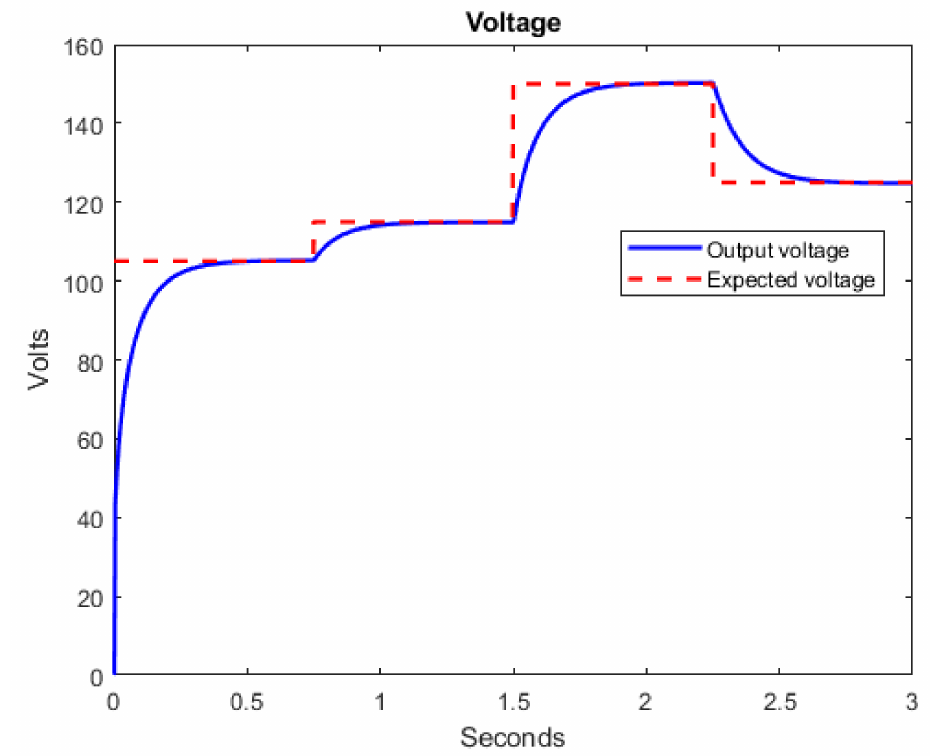
Figure 6. Boost converter under changes in the voltage reference, using the K’s coefficients of the linear adjustment